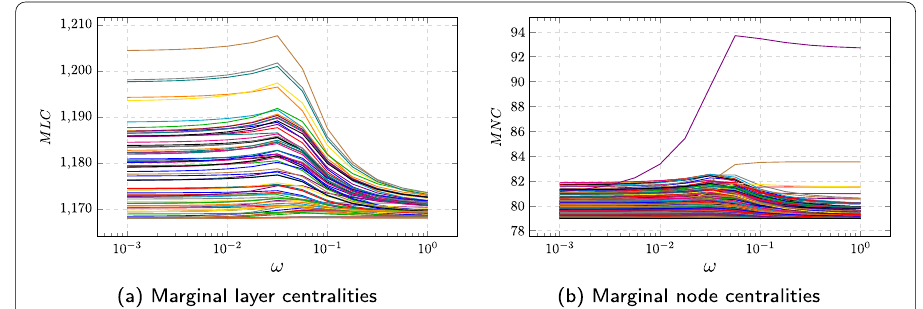
Fig. 12 Marginal layer and marginal node total communicabilities of Chemnitz with varying coupling parameter ω . The entries in the supra-adjacency matrix are weighted with travel times only. The remaining hyper-parameters are chosen as β = 0.5 / (cid:31) max and σ = 1 . The largest MNC for ω > 5 · 10 − 3 corresponds to the stop “Zentralhaltestelle” (engl.: “central